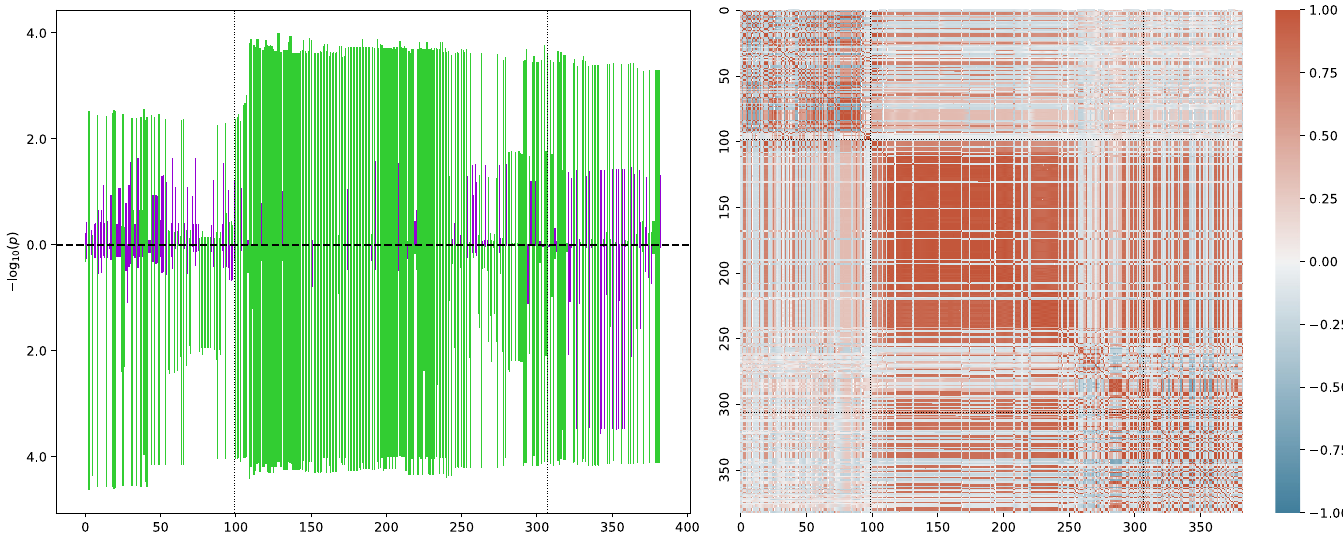
Fig 6. Left: SNP p -values after rank transform for the CCR3 gene. The x -axis is numbered according to the i th SNP in the gene window ordered by increasing position. The dotted black lines indicate the transcription start and end positions (first and last SNP). Up bars correspond to M05B and down bars to severe COVID-19. Green indicates positive and violet negative association with the trait. Right: SNP-SNP correlation matrix inferred from the 1KG reference panel. The color scale is shown on the right with dark red (+1) corresponding to perfect SNP-SNP correlation and dark blue ( − 1) to perfect anti-correlation over the reference population.